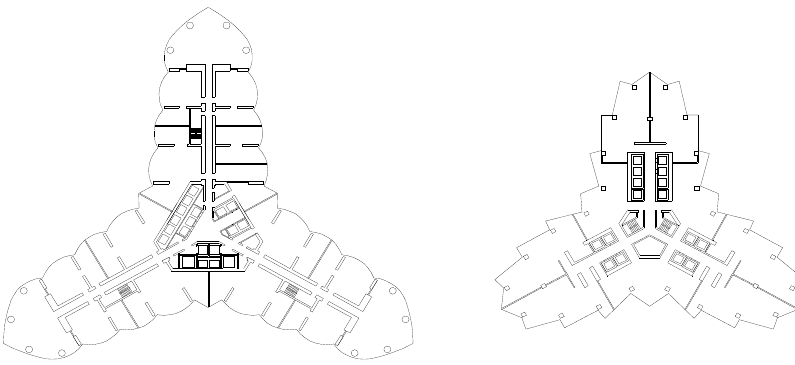
Figure 7. Typical Floor Plans of the Burj Khalifa ( left ) and Samsung Tower Palace ( right